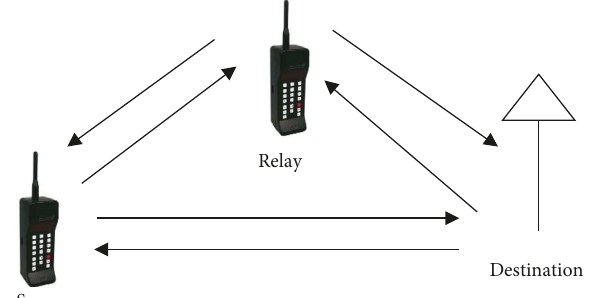
Figure 1: Cooperative relay